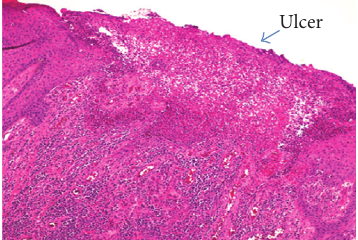
Figure 2: Histological sections of the lesion showing acute inflammatory and lymphoplasmacytic infiltrate in the dermis (hematoxylin-eosin (HE)), original magnification ×